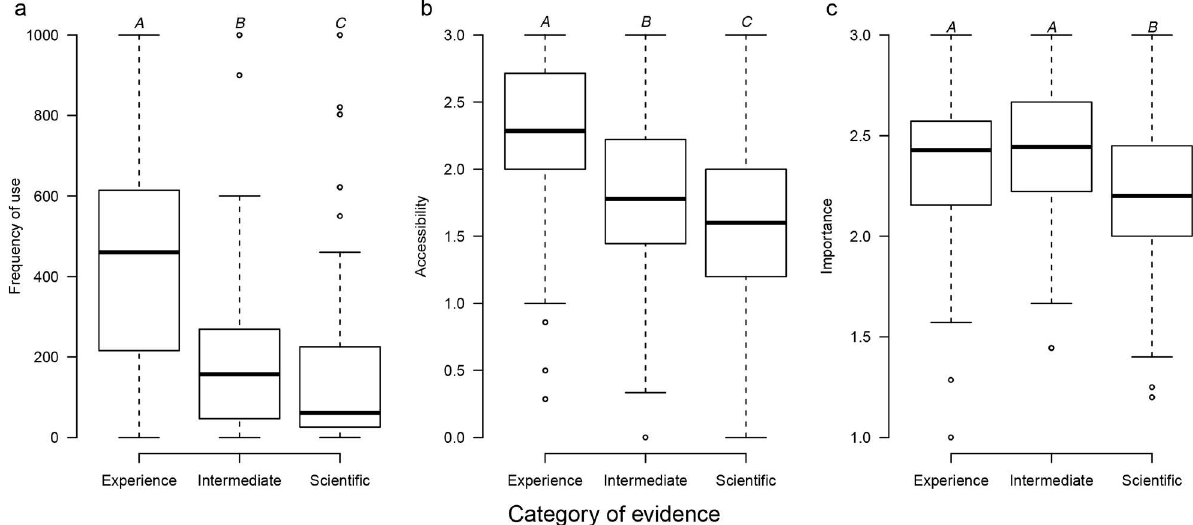
Fig 1. Frequency of use, accessibility, and importance of evidence categories reported by Brazilian managersof protected areas. (a) Frequency of use by evidencecategory (scientific evidence,intermediateand experience).(b) Accessibilityby evidence category. (c) Importance by evidencecategory. All three variablesdiffered amongevidencecategories. Letters aboveboxplotsindicate which pairwise comparisons were significantly different after Tukey tests.